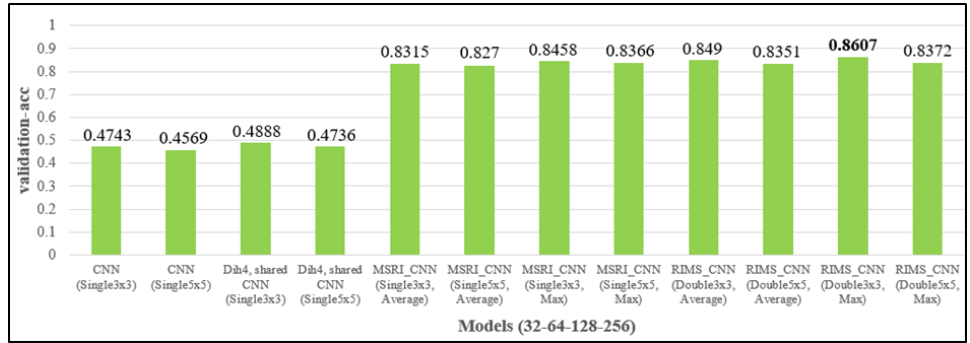
Figure 13. The results of different designs validated on the fixed-angle-rotated FASHION-MNIST.